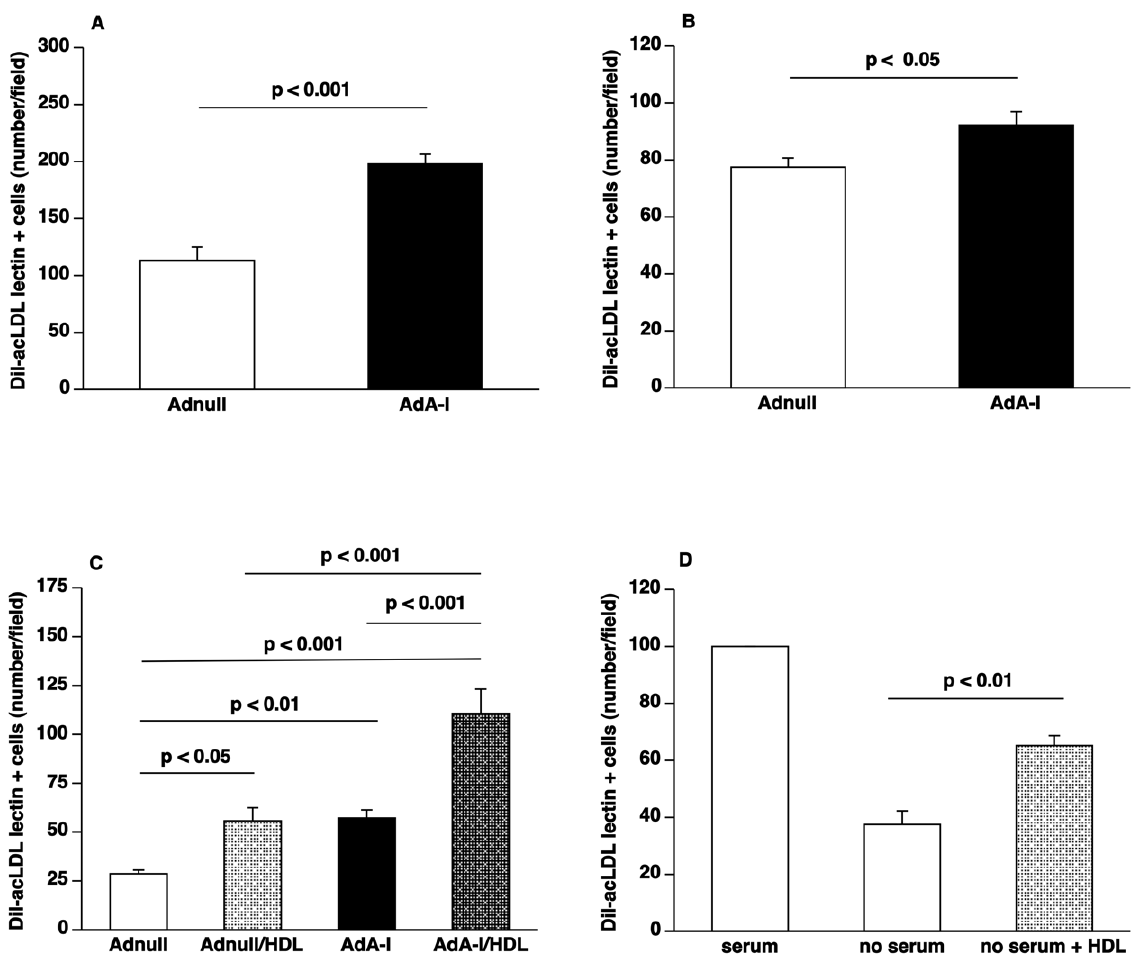
Figure 2. HDL raising gene transfer increases EPC number and enhances EPC function. ( A ) Bar graph showing the number of Dil-acLDL FITC-isolectin double positive cells after 7 days of ex vivo culture of spleen mononuclear cells isolated at day 14 after Adnull transfer or AdA-I transfer in C57BL/6 LDLr 2 / 2 mice (n=6 for each group). ( B ) Bar graph illustrating the number of Dil-acLDL FITC-isolectin double positive cells after 7 days of ex vivo culture of bone marrow mononuclear cells isolated at day 14 after Adnull transfer or AdA-I transfer in C57BL/6 LDLr 2 / 2 mice (n=10 for each group). ( C ) Bar graph showing the number of migrated EPCs in modified Boyden chambers. After 7 days of culture, spleen EPCs isolated from Adnull injected mice (n=5) or AdA-I treated mice (n=6) were seeded in the upper chamber. The lower chamber was supplemented with either HDL (100 m g/ml) or an equivalent amount of bovine serum albumin and the number of migrated cells per microscopy field was quantified after 5 hours. ( D ) Bar graph illustrating the number of surviving murine EPCs. After 7 days of culture, spleen EPCs isolated from C57BL/6 LDLr 2 / 2 mice (n=5) were cultured for 24 hours in EGM-2MV medium or medium without serum and growth factors either supplemented with HDL (100 m g/ml) or bovine serum albumin (100 m g/ml). The number of FITC-isolectin positive cells per microscopy field was quantified after 24 hours in a blinded